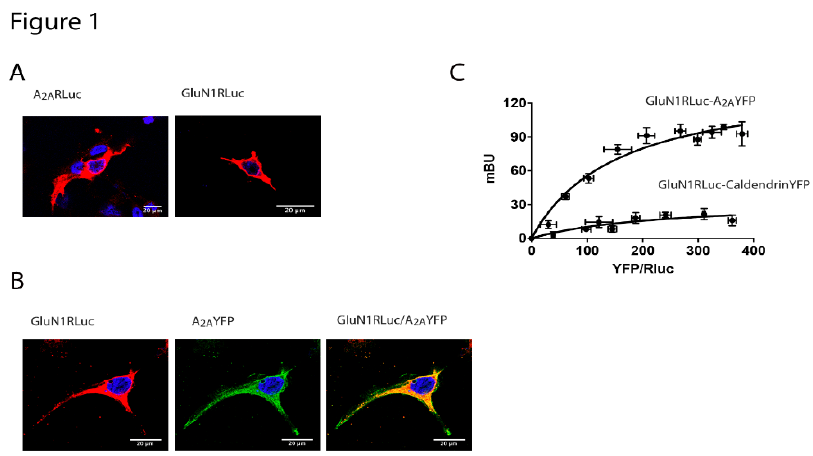
Figure 1. The N -methyl d -aspartate (NMDA) and the adenosine A 2A receptors interact to form heteromeric complexes. In ( A , B ), HEK-293T cells were transfected with 0.5 µ g cDNA corresponding to the A 2A receptor (A 2A R)- Renilla luciferase (RLuc) ( A left ) or 0.5 µ g cDNA corresponding to the GluN1-RLuc in the presence of 0.3 µ g cDNA corresponding to GluN2 ( A right ) or co-transfected with 0.4 µ g cDNA for A 2A R-yellow fluorescent protein (YFP) and 0.4 µ g cDNA corresponding to the GluN1-RLuc in the presence of 0.25 µ g cDNA corresponding to the GluN2 ( B ). Confocal microscopy images are shown. The receptors fused to RLuc were identified by immunocytochemistry (red) and the proteins fused to YFP were identified by its own fluorescence (green). Colocalization is shown in yellow in the merge image. Scale bar: 20 µ m. In ( C ), the bioluminescence resonance energy transfer (BRET) saturation experiments were performed in HEK-293T cells transfected with 0.3 µ g of cDNA corresponding to the GluN1-RLuc, 0.2 µ g of cDNA corresponding to the GluN2 and increasing amounts of cDNA corresponding to A 2A R-YFP (0.1 µ g to 0.5 µ g) or caldendrin-YFP (0.1 µ g to 0.7 µ g) as a negative control. The relative amount of BRET is given as a function of 1000 × the ratio between the fluorescence of the acceptor (YFP) and the luciferase activity of the donor (RLuc). BRET is expressed as milli BRET units (mBU) and is given as the mean ± SEM of 6 di ff erent experiments grouped as a function of the amount of BRET